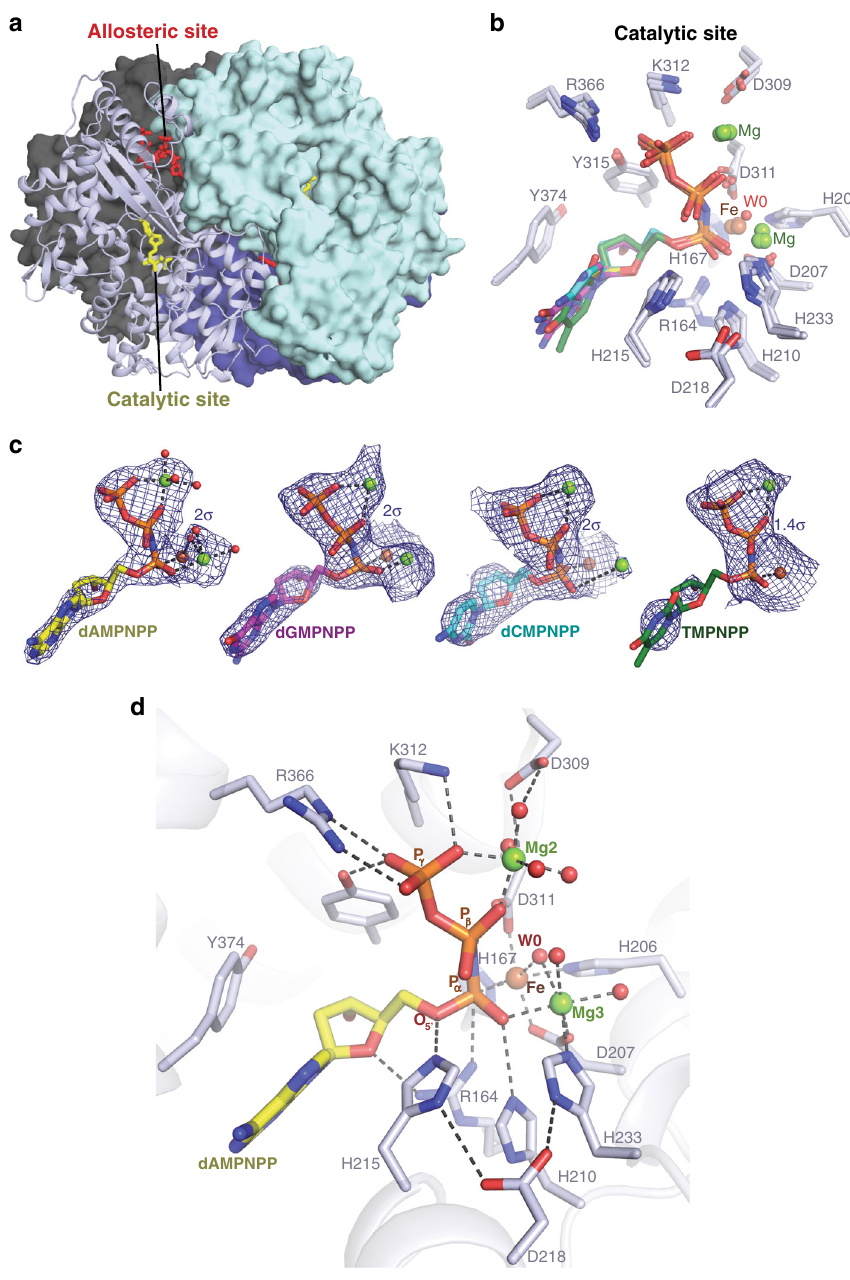
Fig. 3 Crystal structures of SAMHD1 – dNMPNPP inhibitor complexes. a Crystal structure of D137N-SAMHD1(109-626)-XTP-dAMPNPP inhibitor complex tetramer. Three monomers are shown in surface representation with a single monomer shown in cartoon representation. Monomers are coloured cyan, dark grey, dark blue and light blue, respectively. Nucleotides bound at the active and allosteric site in the cartoon monomer are shown in stick representation and coloured yellow and red, respectively. b Structural alignment of the active sites of the D137N-SAMHD1(109-626)-XTP-dAMPNPP, D137N-SAMHD1(109-626)-XTP-dGMPNPP, wt-SAMHD1(109-626)-GTP-dATP-dCMPNPP and wt-SAMHD1(109-626)-GTP-dATP-TMPNPP structures. Overlapping-bound nucleotides and active-site residues are shown in stick representation. The carbon atoms of the base and sugar of the bound nucleotides are coloured: yellow, dAMPNPP; magenta, dGMPNPP; cyan, dCMPNPP: and green, TMPNPP. c Simulated-annealing composite omit 2 F o − F c electron density (blue mesh) for active site-bound nucleotides in D137N-XTP-dAMPNPP, D137N-XTP-dGMPNPP, wt-GTP-dATP-dCMPNPP and wt-GTP- dATP-TMPNPP structures. Nucleotides are shown in stick representation and colour coded as in b . Metal ions are shown as spheres (Mg, green; Fe, brown). d Detailed view of the active site of the D137N-SAMHD1(109-626)-XTP-dAMPNPP inhibitor complex. The protein backbone is shown in cartoon representation, bound nucleotides and active site residues are shown in stick representation, metal ions and ordered water molecules as spheres, coloured by atom type (oxygen, red; Mg, green; Fe, brown). Hydrogen bonding and metal ion coordinate bonds are shown as dashed lines. W0 indicates the in-line attacking nucleophilic water